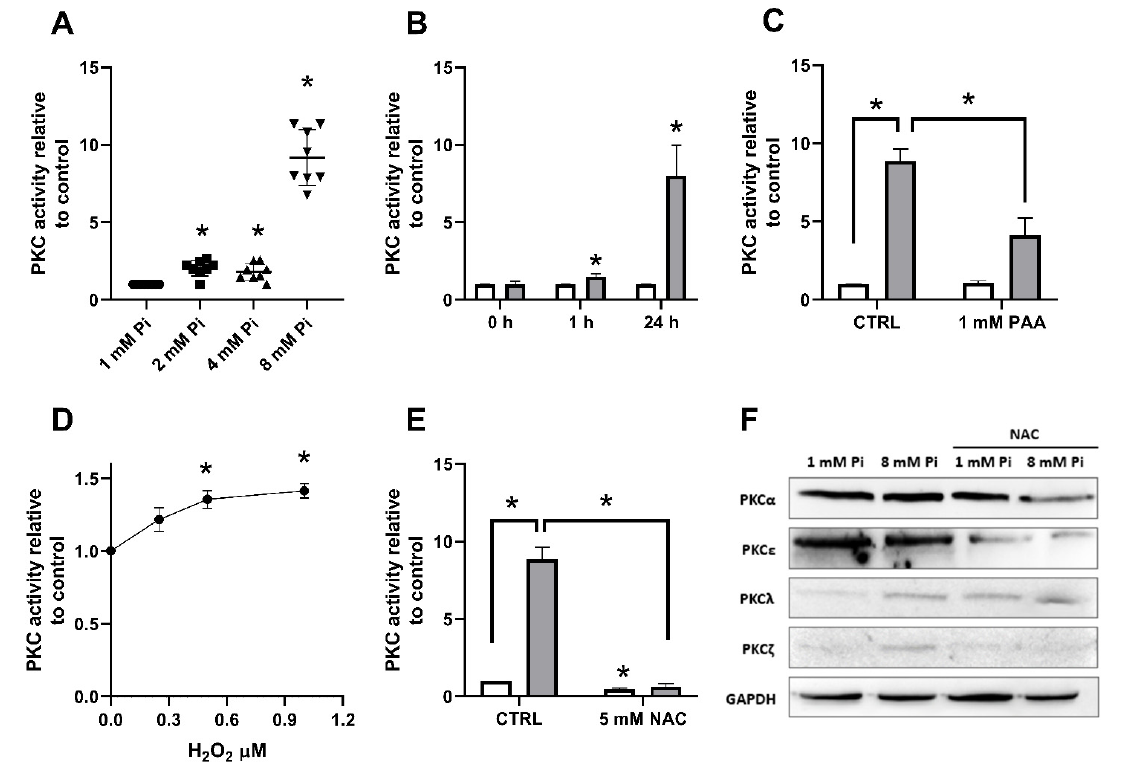
Figure 8. PKC is involved in Pi-induced H 2 O 2 production in MDA-MB-231 cells. PKC activity was measured, as described in Section 4, in MDA-MB-231 cells treated with various Pi concentrations (1, 2, 4, or 8 mM Pi) for 24 h ( A ); or with 1 mM (white bars) or 8 mM Pi (grey bars) for 1 h or 24 h ( B ). The same conditions were evaluated (1 mM Pi—white bars, 8 mM Pi—grey bars) in the absence (control) or presence of PAA (1 mM) for 24 h ( C ). Increasing H 2 O 2 concentrations (0–1 µ M) were added in the reaction mixture and PKC activity was analyzed for 10 min ( D ). MDA-MB-231 cells were treated with 1 mM (blank bars) or 8 mM Pi (grey bars) in the absence (control) or presence of NAC (5 mM) for PKC activity evaluation ( E ). Representative immunodetections of PKC isoforms: PKC α , PKC ε , PKC λ , and PKC ζ , in cells maintained at 1 mM or 8 mM Pi, in the presence or absence of NAC for 24 h. GAPDH was used as loading control ( F ). Bars represent mean ± SE of at least 3 independent biological samples. * p < 0.05 indicates changes significantly different, as assessed by ANOVA followed by Tukey’s multiple comparison test.